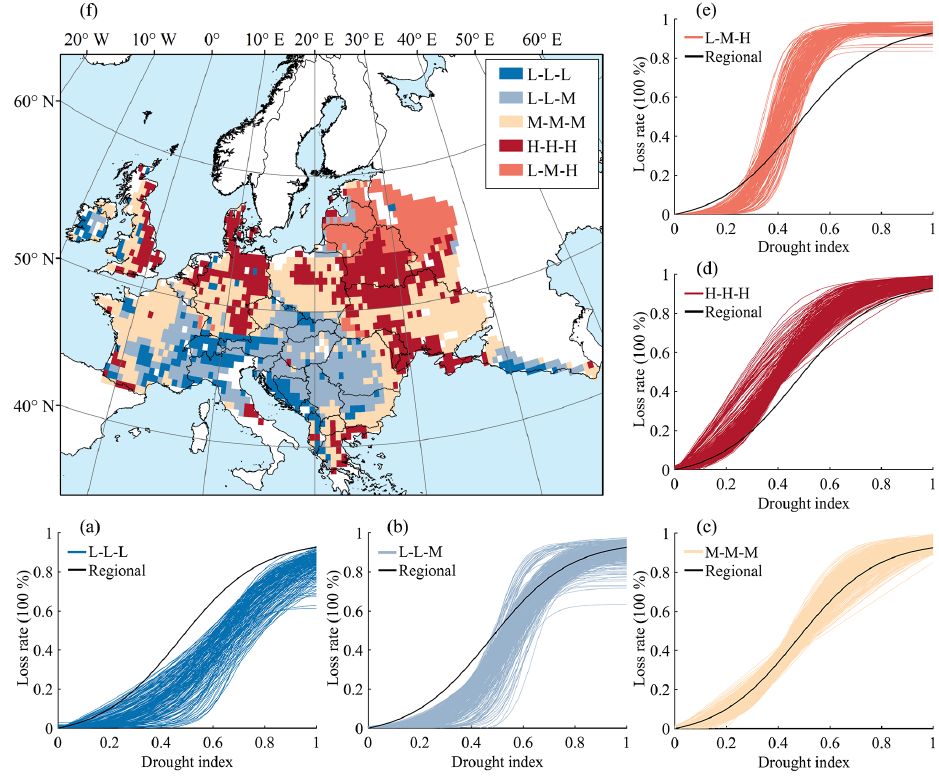
Figure 8. Five types of European winter wheat vulnerability curves to drought: (a) L-L-L, (b) L-L-M, (c) M-M-M, (d) H-H-H, and (e) L-M-H loss-type vulnerability curves and (f) their spatial distributions. Table 4. Correlation between vulnerability characteristic parameters and environmental variables ( P ≤ 0 .